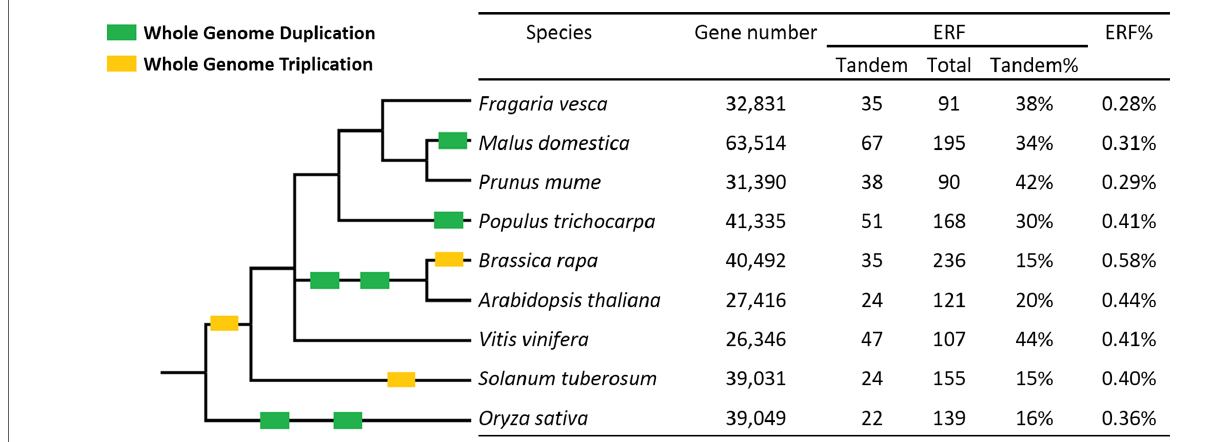
FIGURE 7 | Percentages of tandem ERF genes in the nine species investigated. ERF% shows the percentage of ERF genes in the total gene set. The Taxonomy Common Tree constructed online by Taxonomy Browser in the National Center for Biotechnology Information (NCBI; http://www.ncbi.nlm.nih.gov/ Taxonomy/CommonTree/wwwcmt.cgi) is on the left. The branch length is not proportional to the evolutionary time. Green box, whole-genome duplication; yellow box, whole-genome